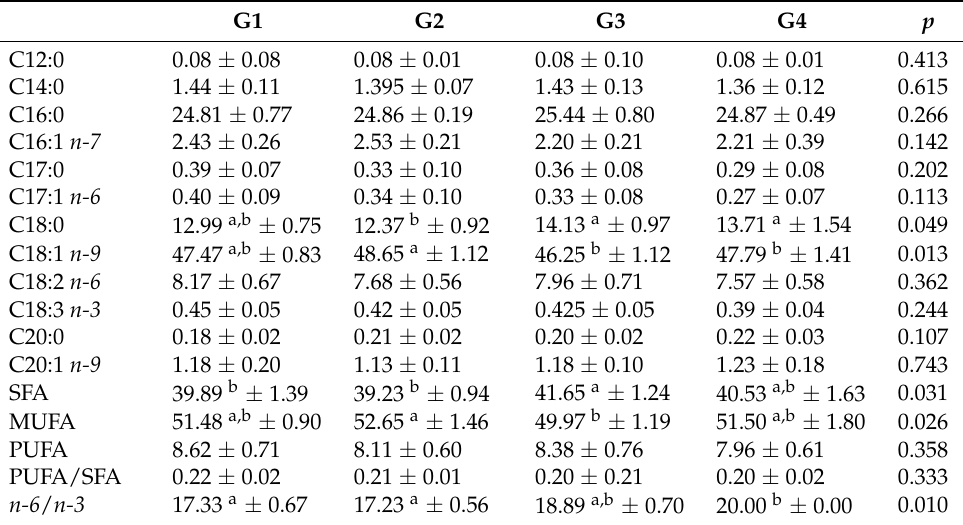
Fatty acid profile (mean ± standard deviation) of subcutaneous fat from dietary experimental